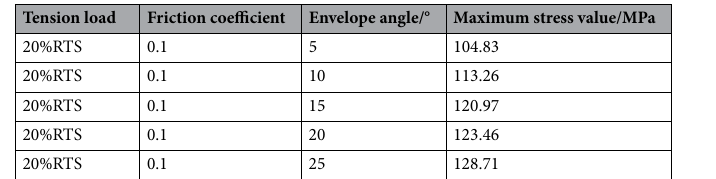
Table 5. Maximum equivalent stress of aluminum strand under different envelope